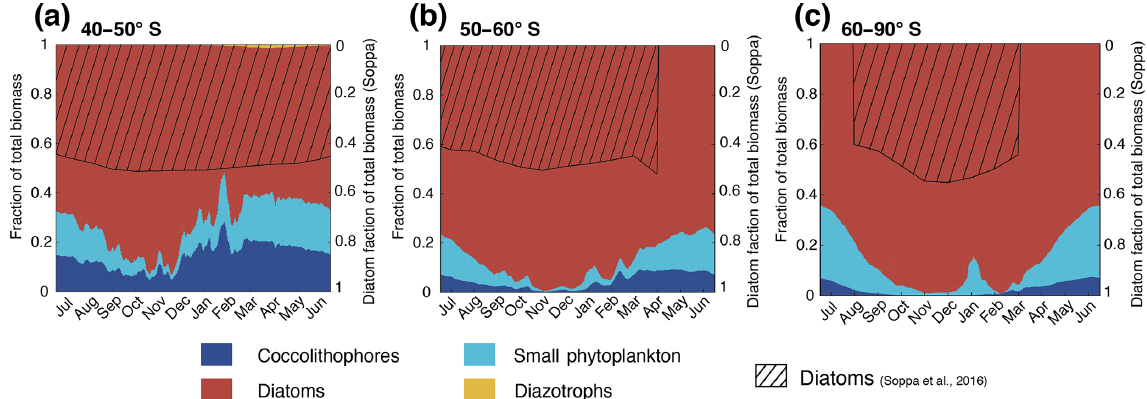
Figure 3. Relative contribution of the four phytoplankton PFTs to total surface chlorophyll biomass (mgChlm − 3 ) for (a) 40–50 ◦ S, (b) 50– 60 ◦ S, and (c) south of 60 ◦ S. Shaded areas (right axis) depict the contribution of diatoms to total surface chlorophyll derived from monthly climatological MODIS Aqua chlorophyll (Johnson et al., 2013) using the algorithm by Soppa et al. (2016). For months without shading, no satellite data are